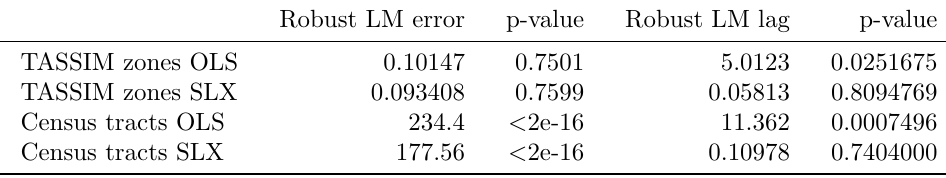
Table A.8: Robust Lagrange Multiplier tests for omitted spatial error and spatial lag terms in unweighted least squares regression models with and without the spatially lagged independent variables for the 489 census tract data set and the 96 TASSIM zone data